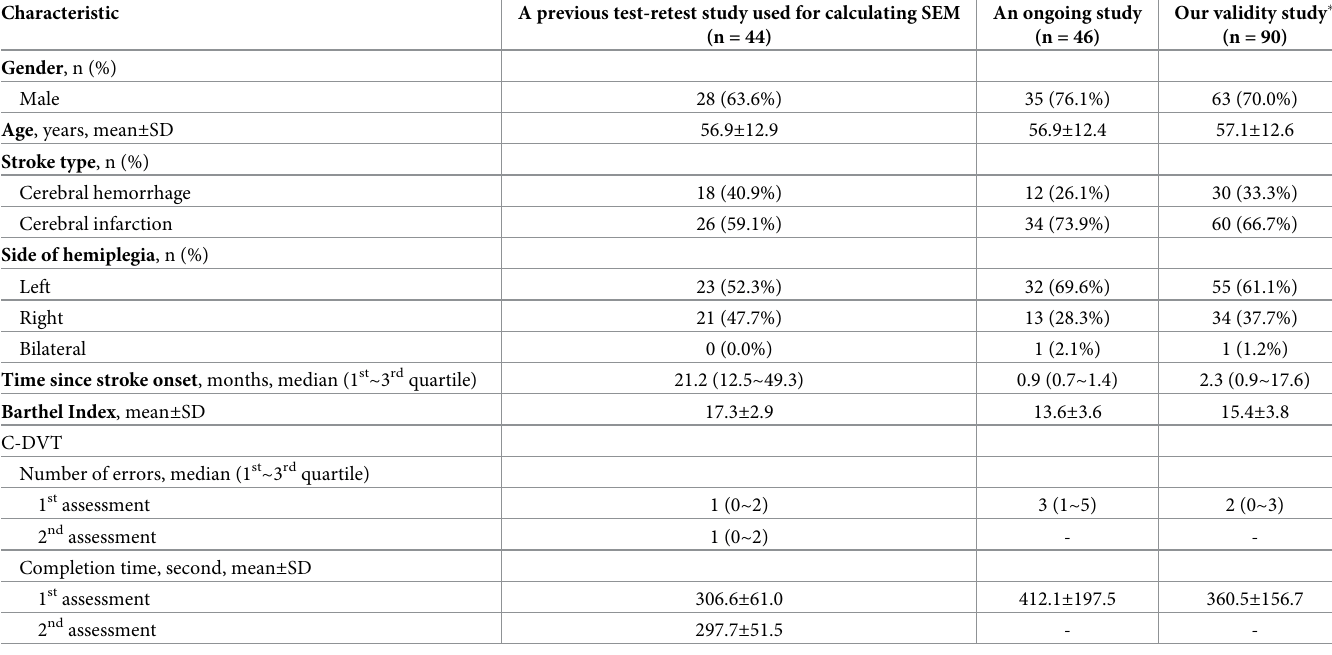
Table 1. Demographic characteristics and stroke-related information of the patients.